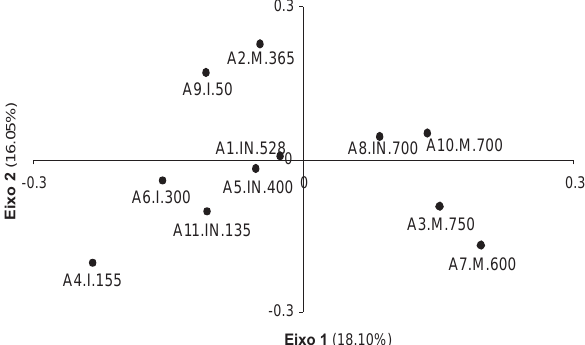
Figure 2. Correlation scores between the remnants of the Atlantic Forest of the hydrographic basin of the Itajaí River, Santa Catarina, sampled in the present study, and axis 1 of the Correspondence Analysis diagram, evaluating mixed species flock composition. The letters M, IN and I are initials for massive fragment, intermediate fragment and isolated fragment, respectively. Numbers following the letters indicate the maximum altitude of each